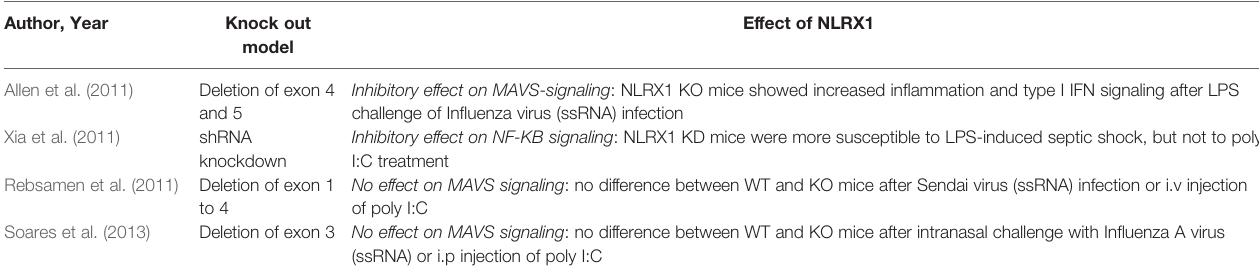
TABLE 1 | Mouse models to study